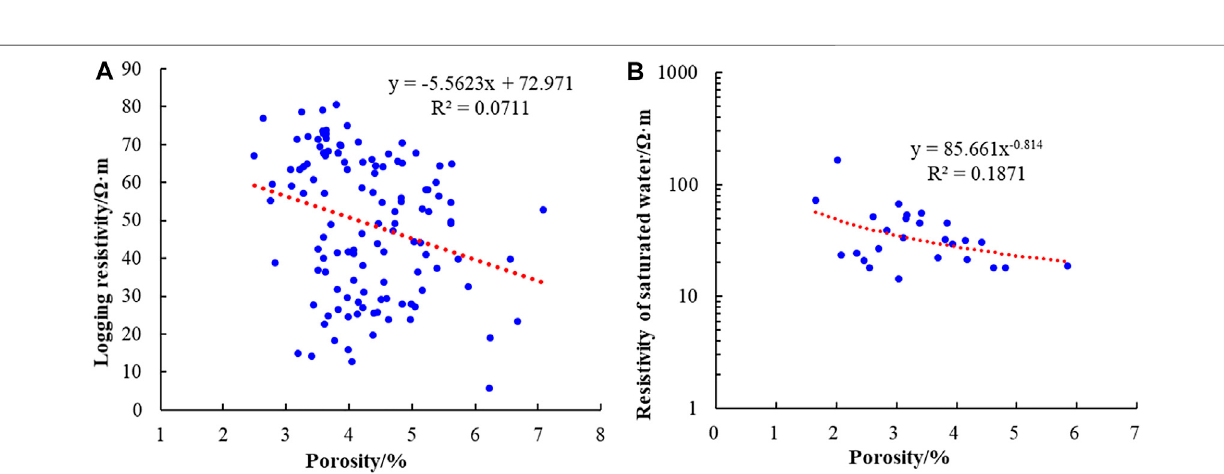
Frontiers in Earth Science |